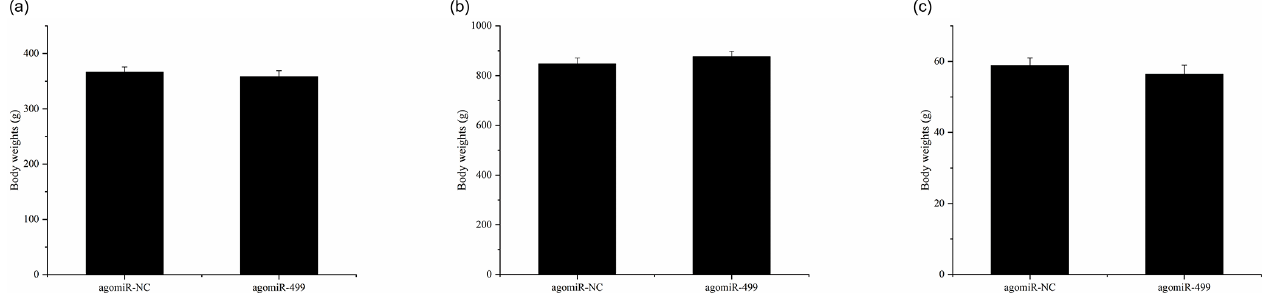
Figure 1. The body weights of chicks in the control group (CG) and treatment group (TG). (a) The body weights of chicks in the two groups at day 1. (b) The body weights of chicks in the two groups at day 18. (c) The leg muscle weights of chicks in the two groups at day 18. The agomiR-NC and agomiR-499 represent the control and treatment groups,